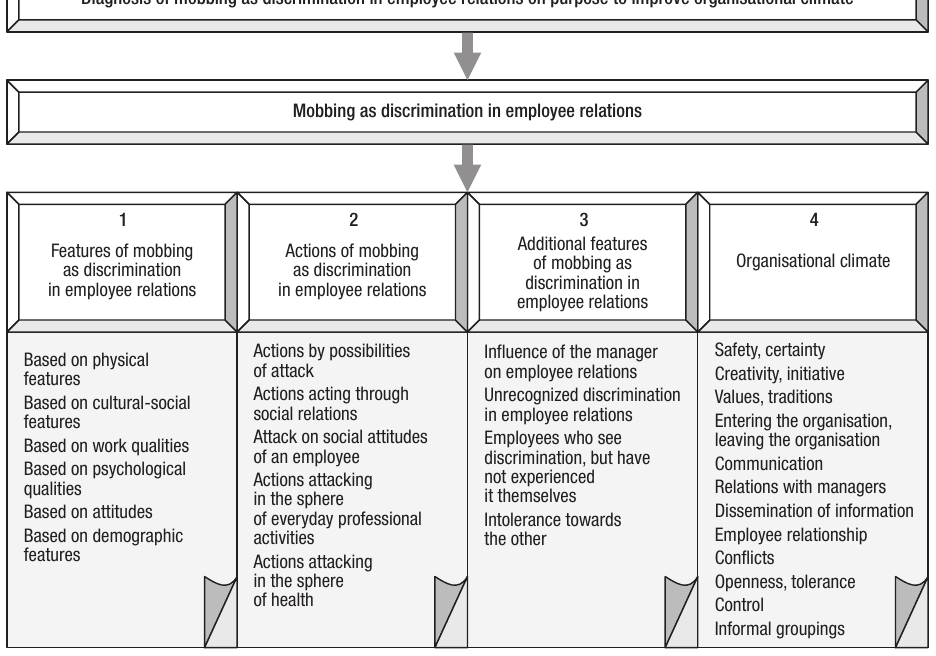
Fig. 2. Characteristics and criteria of the instrument distinguished after expert